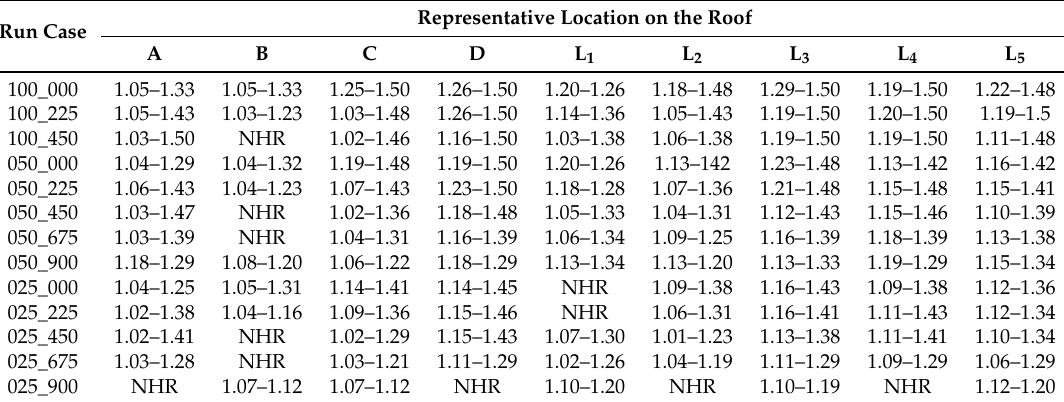
Table A1. Height ranges of relatively favorable wind conditions ( U / U 0 ≥ 0.97 and I U / I 0 ≤ 1) at the representative locations on the roof for all run cases with a prevailing wind direction. The height ranges are normalized by the height of the buildings, H . The height above z / H = 1.50 is not considered. “NHR” stands for “no height range of relatively favorable conditions”.